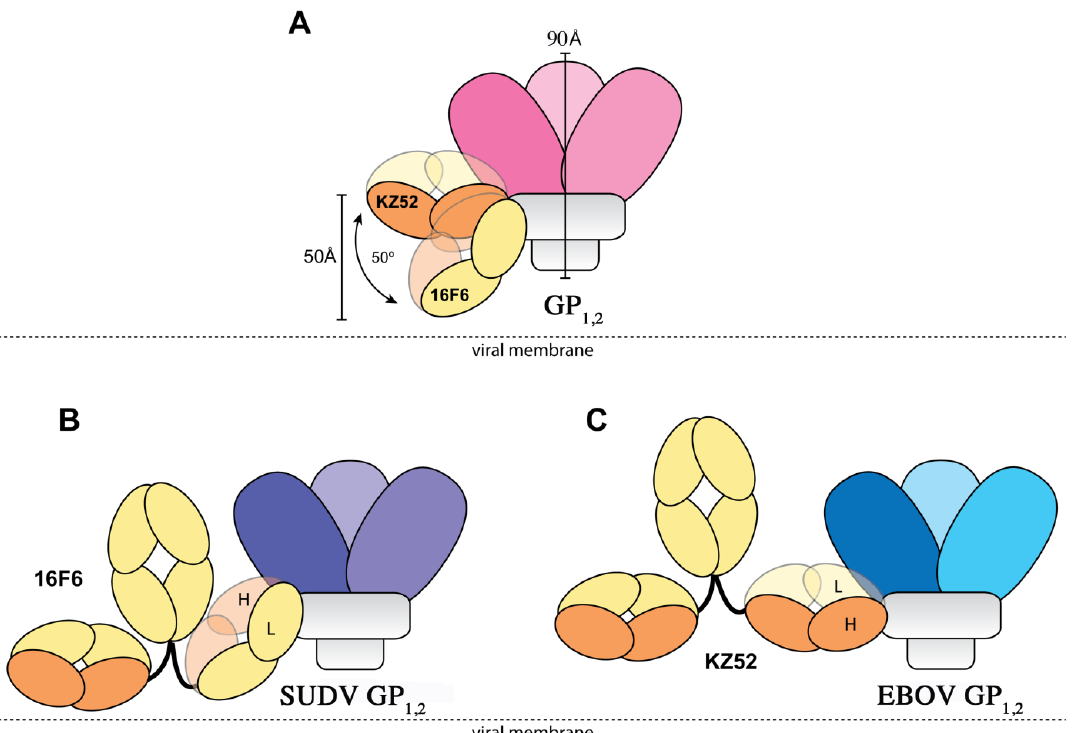
Figure 8. Cartoon illustration of the different modes of antibody binding. (A) KZ52 binds (parallel to the viral membrane), while 16F6 perpendicular to the central axis of GP 1,2 recognizes the overlapping epitope from an acute angle. The central axes of the two Fabs make a 50° angle with each other, and the constant portion of the 16F6 Fab is 50 Å lower than that of KZ52. Fab heavy chains are colored orange, while light chains are colored yellow. Approximate location of the viral membrane is indicated by a dotted line. C that anchor the visualized trimer to the viral membrane are terminal portions of GP 2 (purple) disordered and not drawn here. (B) Model of a 16F6 IgG binding SUDV GP 1,2 complex (PDB: 3VE0). (C) Model of a KZ52 based on the 16F6 Fab-SUDV-Bon GP 1,2 (blue) based on the KZ52 Fab-EBOV-May GP complex IgG binding EBOV-May GP 1,2 1,2 fragments are drawn to scale in the structure (PDB: 3CSY). The IgG and GP 1,2